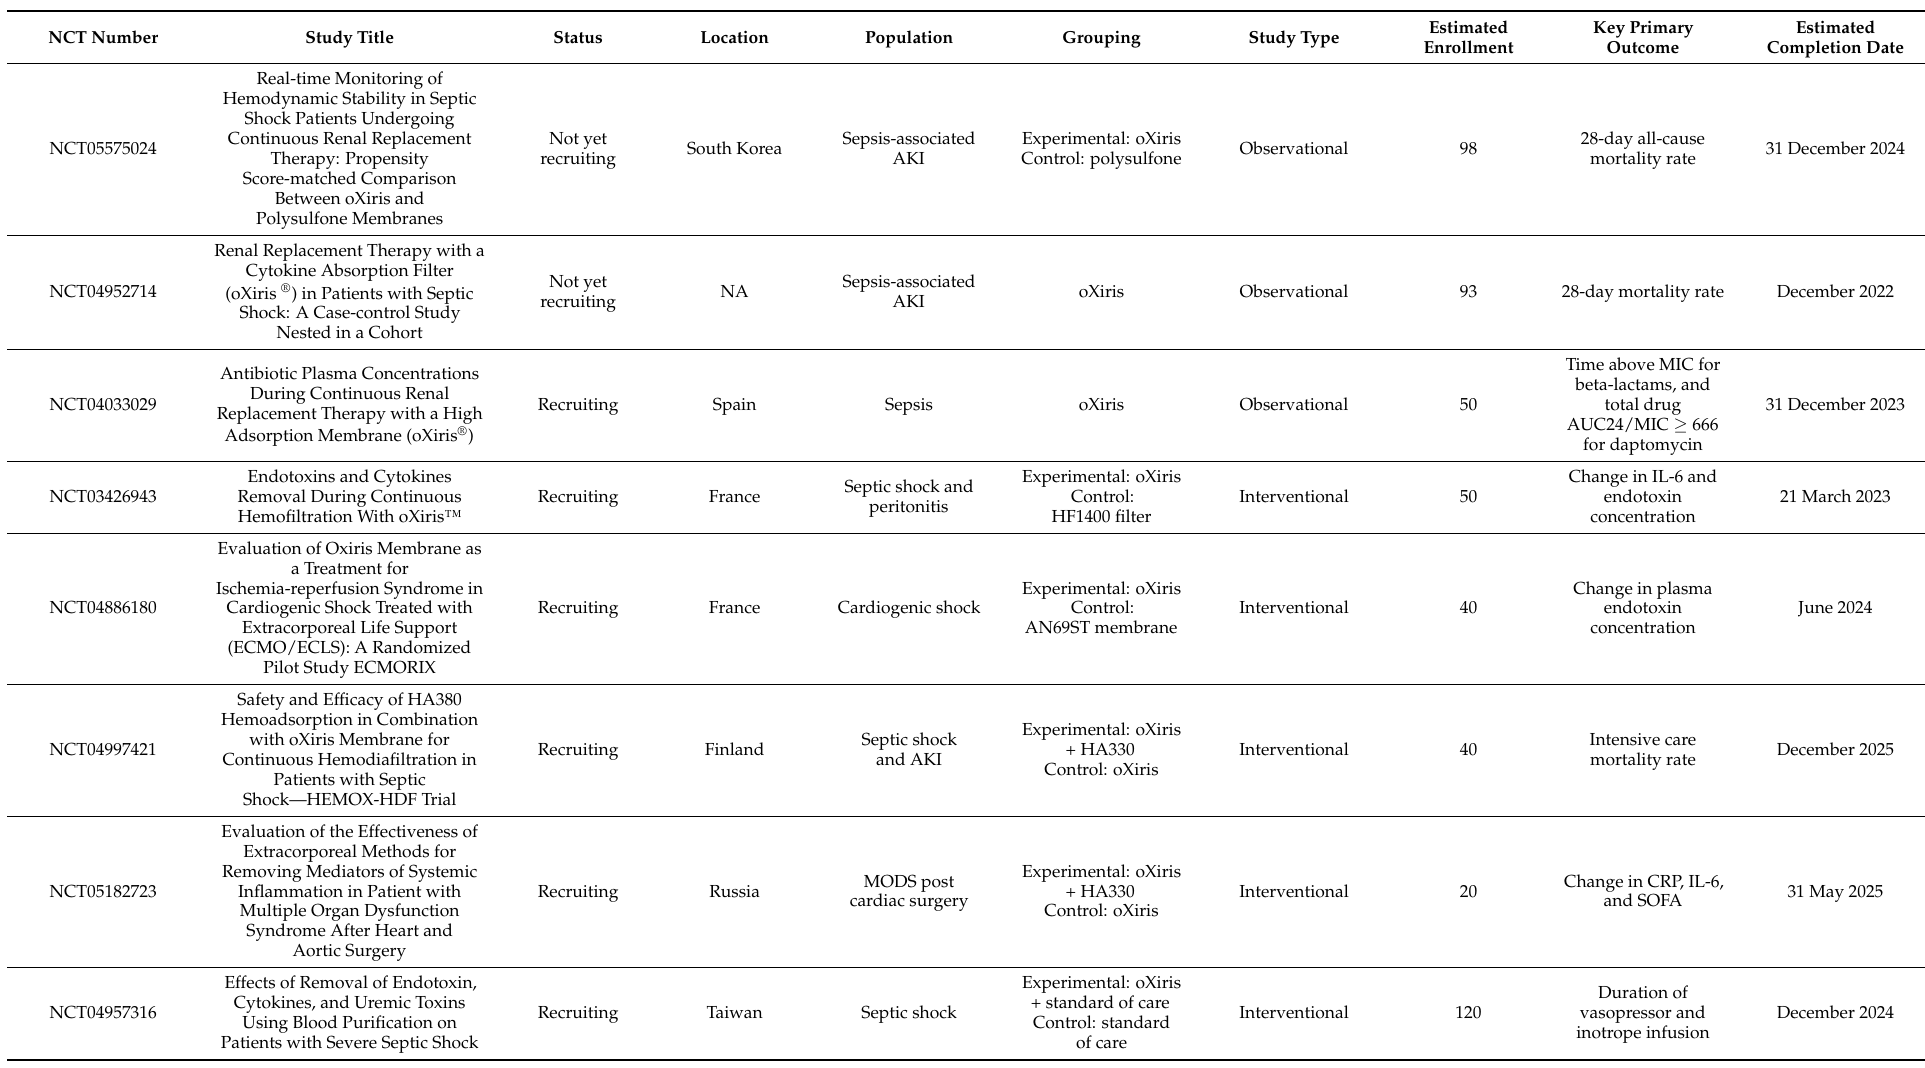
Table 3. Summary of ongoing clinical studies evaluating oXiris-CRRT in critically ill